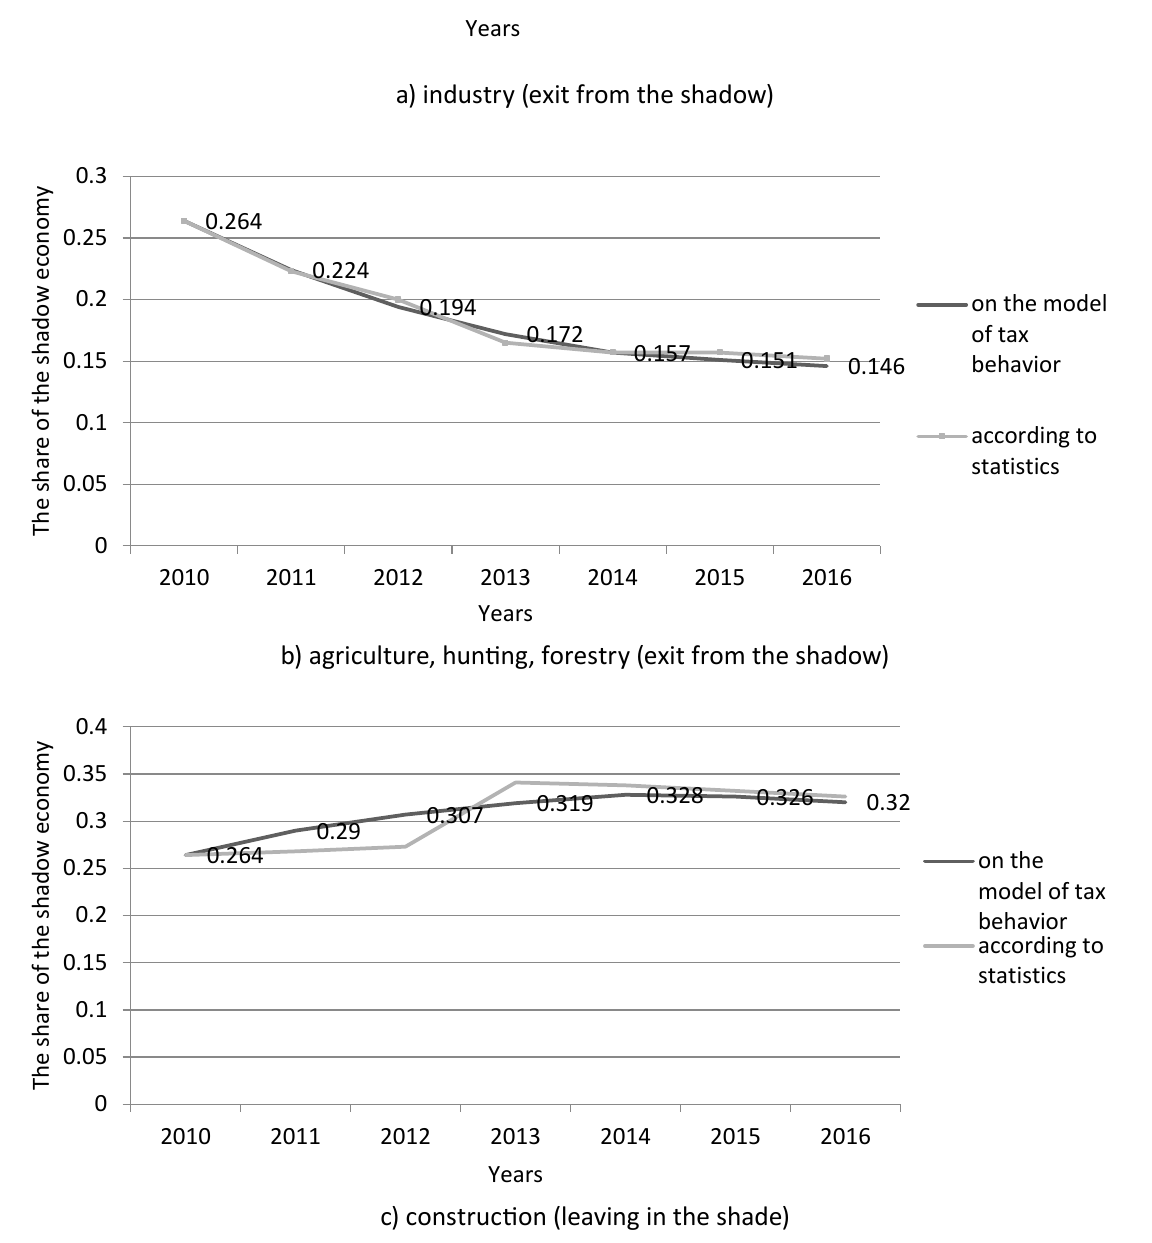
Figure 1. The results of calculating the share of shadow economy by branches of the Kharkiv